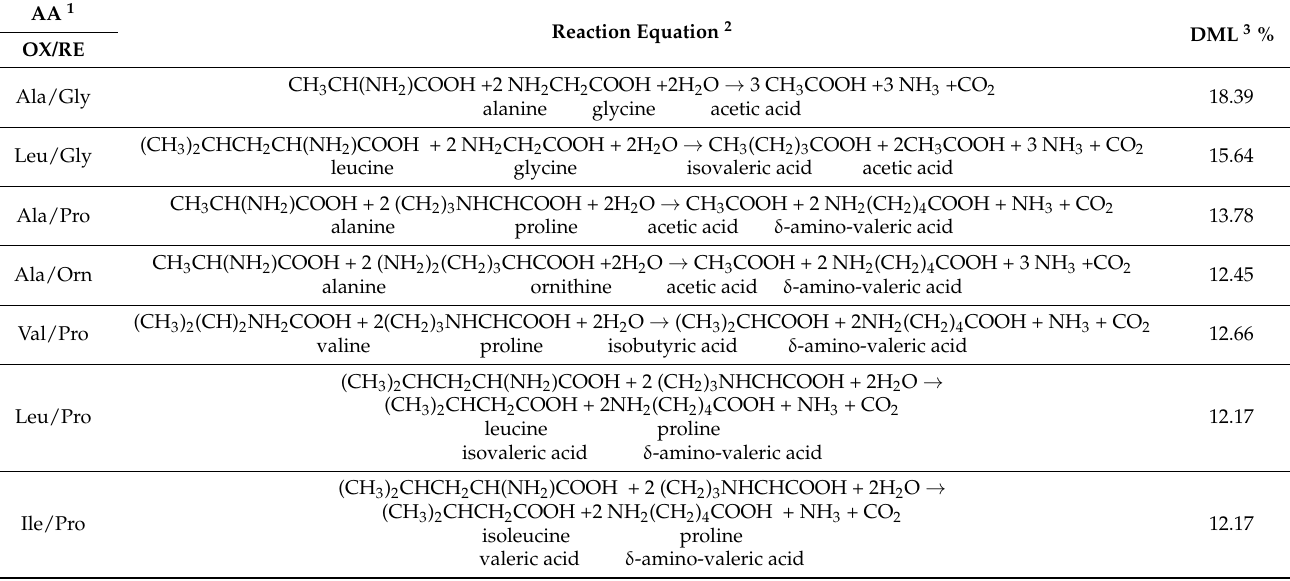
Table 4. Examples of selected Stickland reactions and the related DM losses